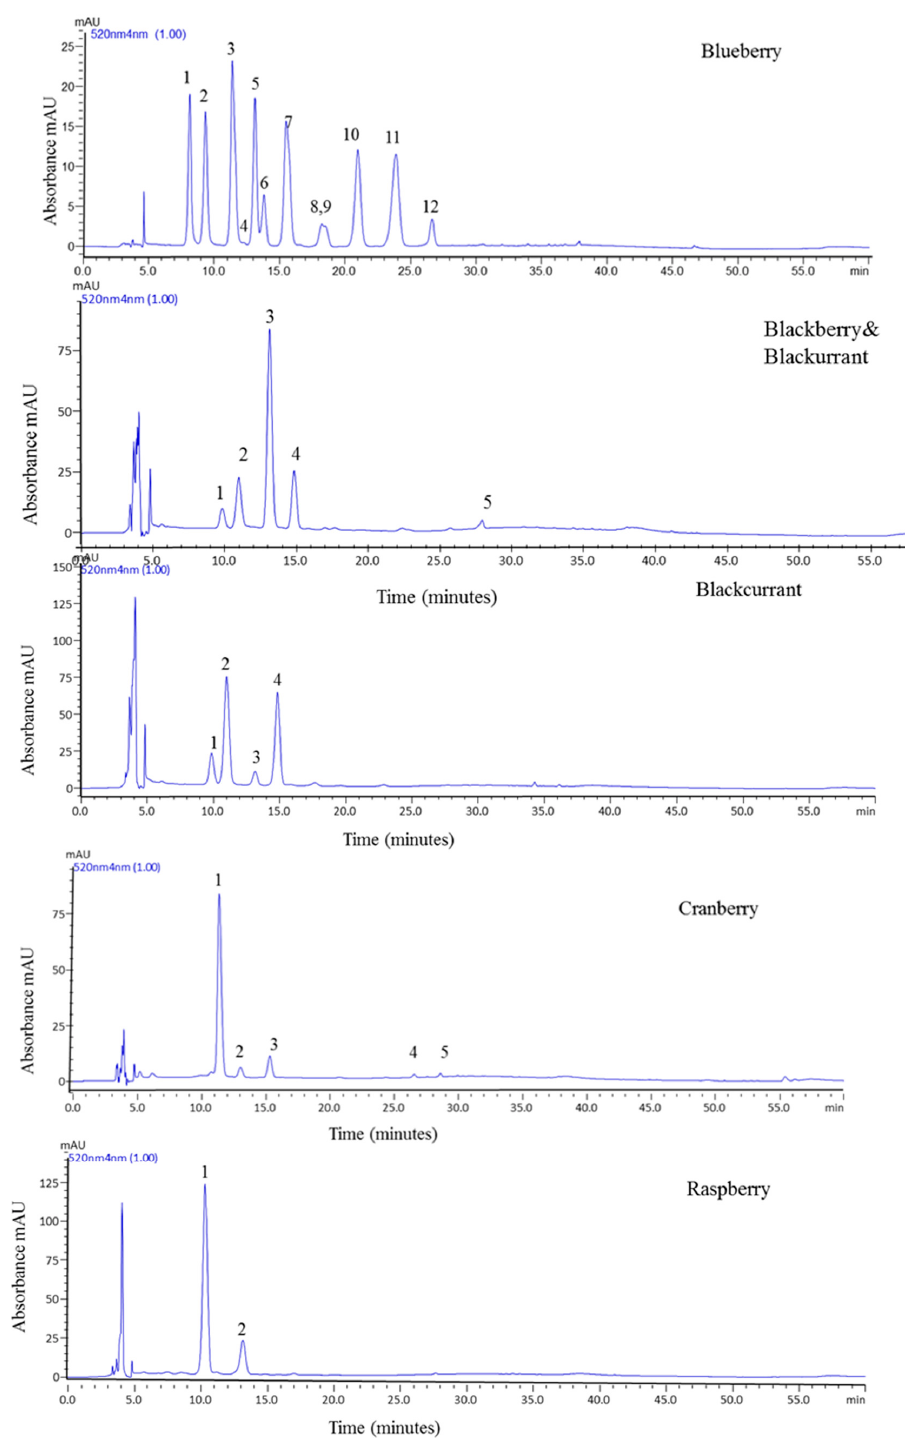
Figure 1. HPLC-PDA chromatograms of jam samples recorded at 520 nm.